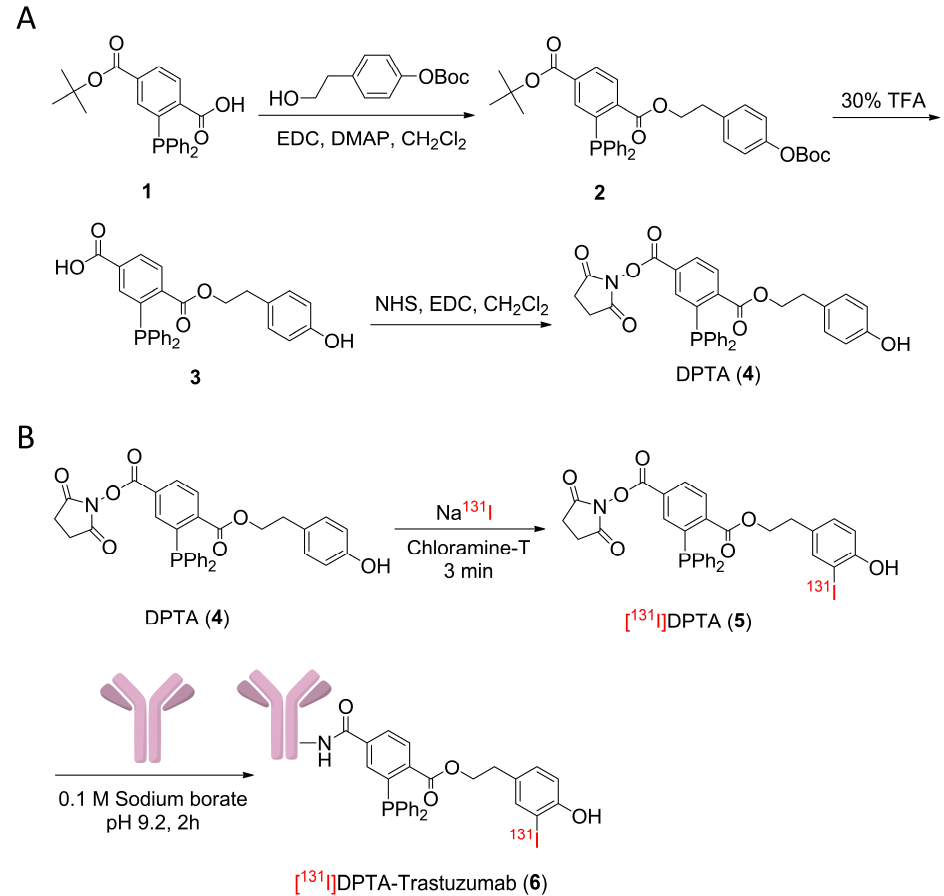
Figure 2. All azide compounds were used for Staudinger ligation screening studies.